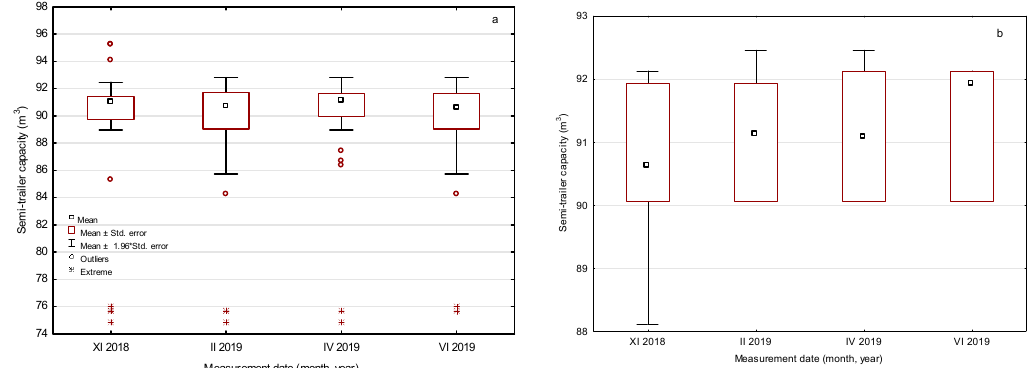
Figure 6. Comparison of semi-trailer capacity values by measurement date for unit A wood chips ( a ); sawdust ( b ).